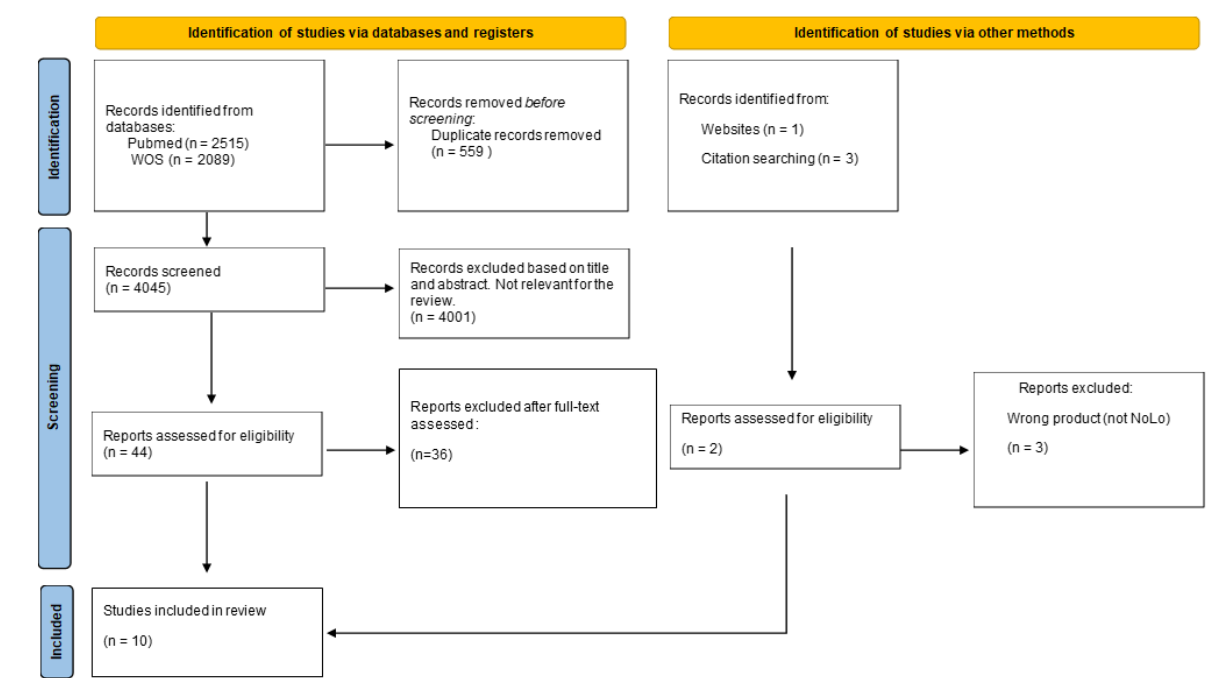
Figure 1. Flow diagram of included studies.